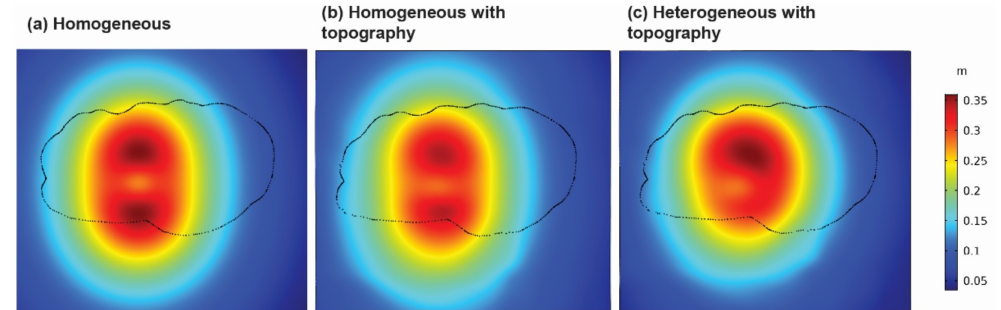
Figure 5. Total displacement at the free surface (top view) from the joint inversion of EDM and leveling data for the period 1985–1999. Black dotted line represents the caldera border. ( a ) Homogeneous model without topography. ( b ) Homogeneous model with topography. ( c ) Heterogeneous model with topography. The color scale (0.05–0.35 m) is the same for the three